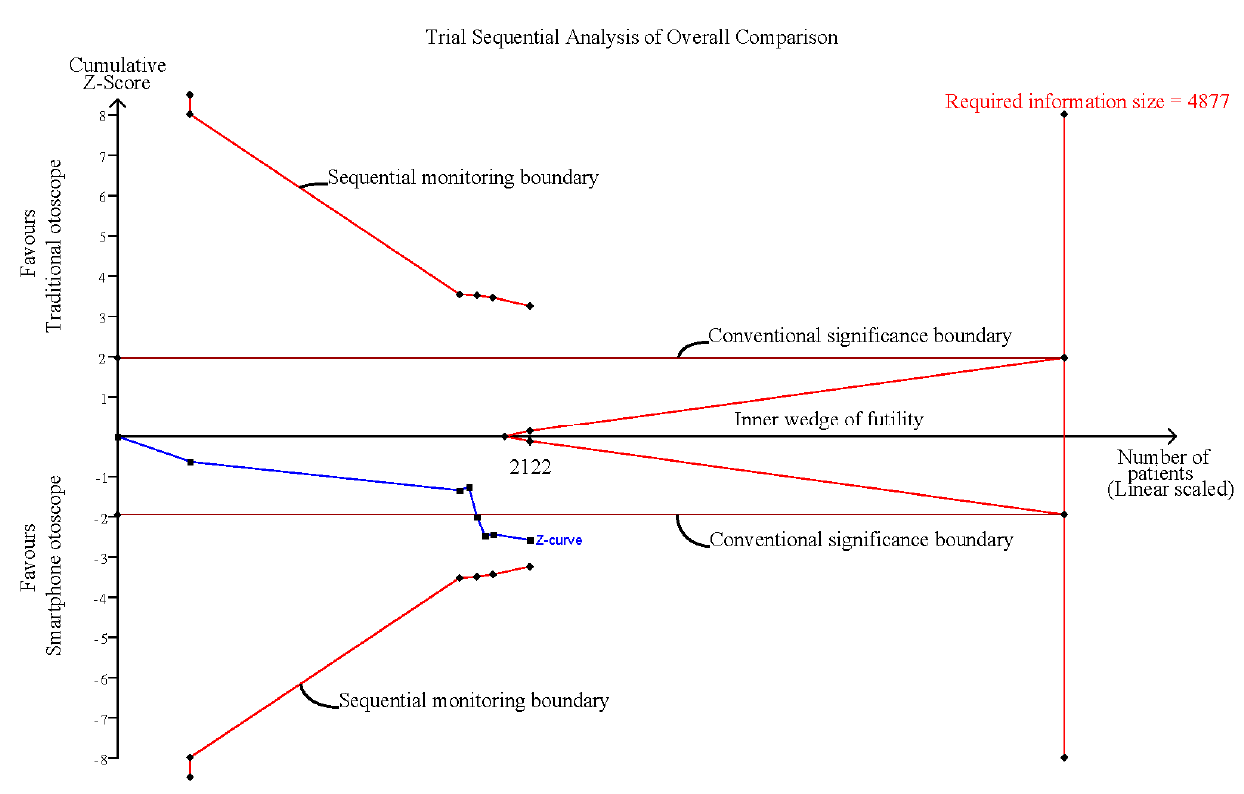
Figure 8. Trial sequential analysis (TSA) of overall comparison between smartphone-enabled otoscopy and traditional otoscopy.